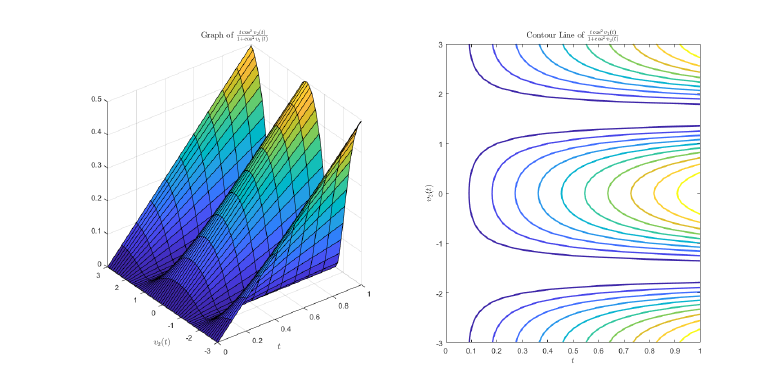
t cos 2 υ 2 ( t ) 1 + cos 2 υ 2 ( t )